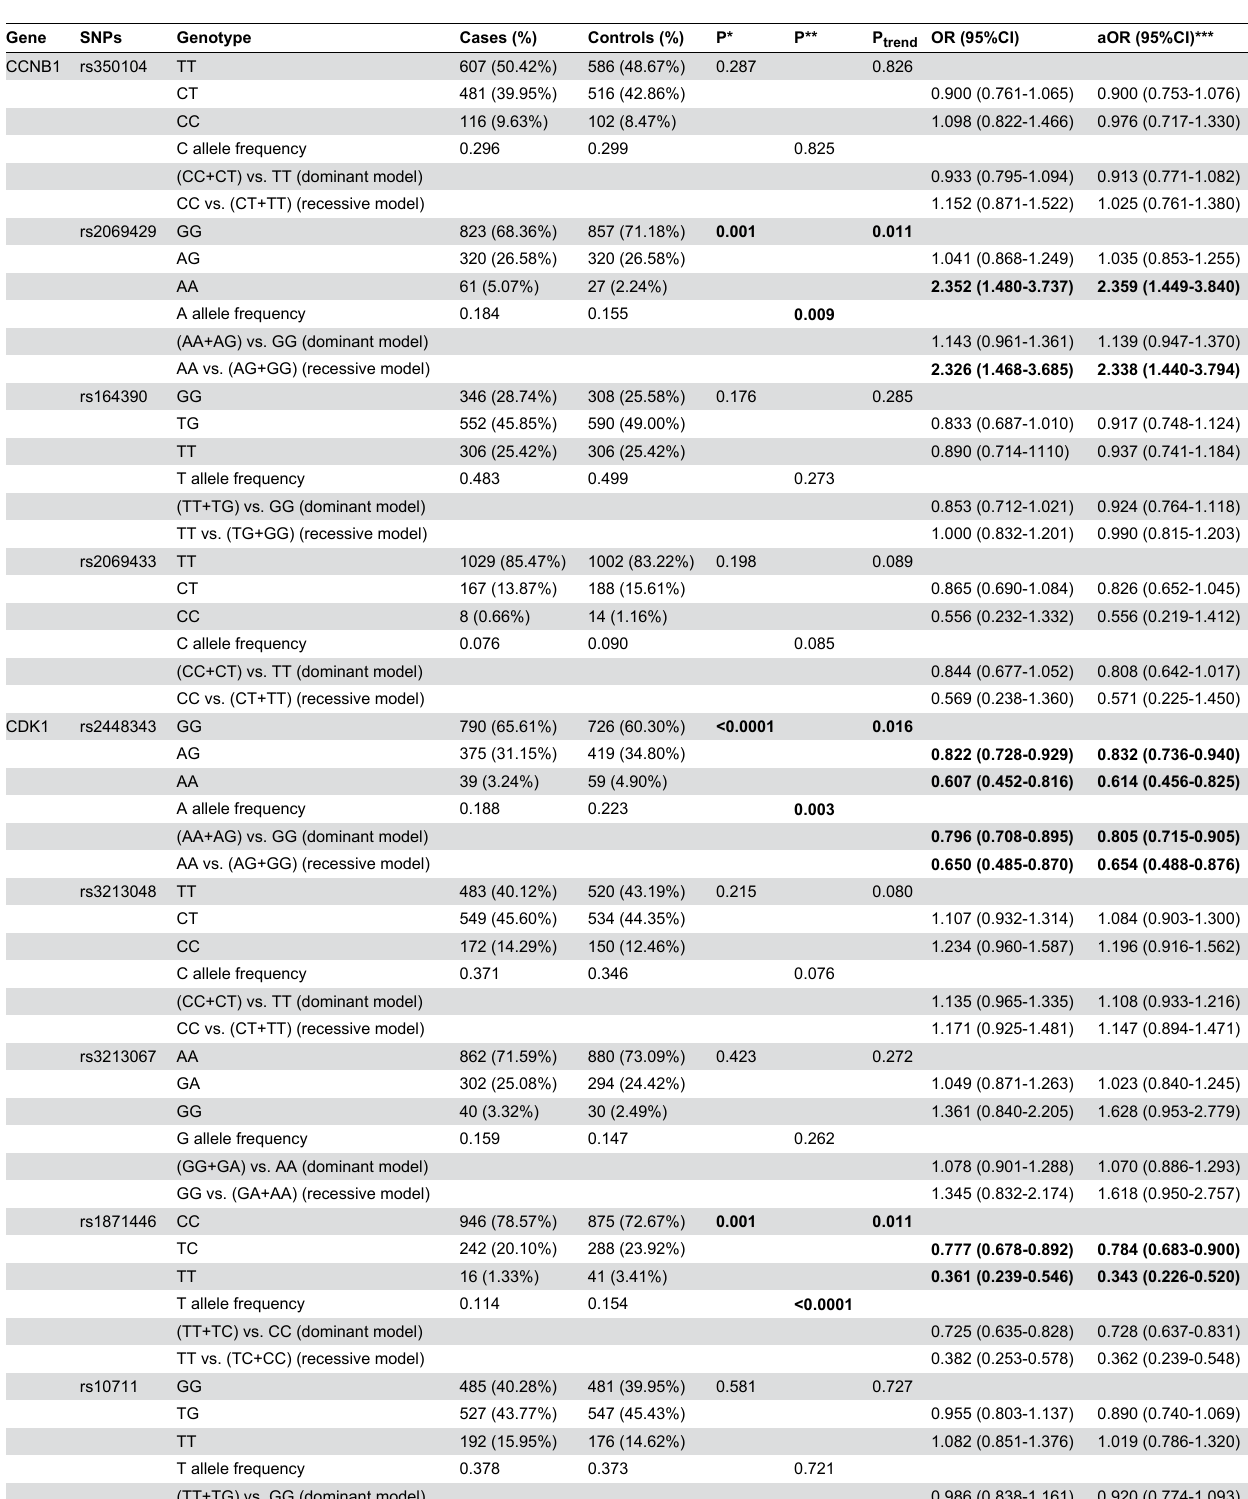
Table 1. Allele and genotype frequencies of the selected tSNPs in CCNB1 and CDK1 and the association with risk of breast